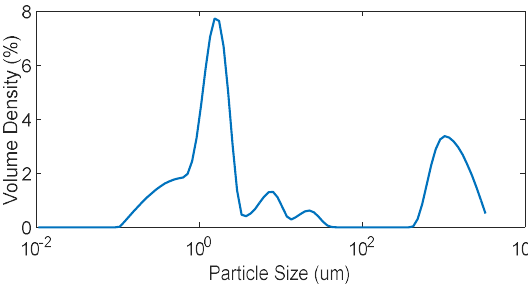
Figure 7. Particle size distribution of TiO 2 .